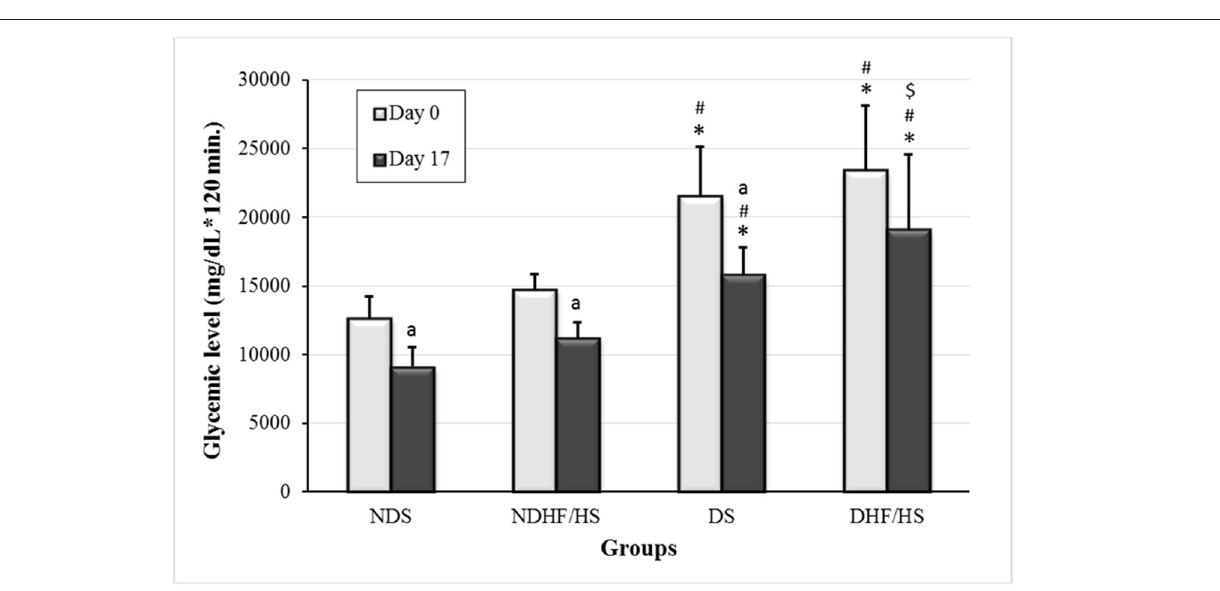
in AUC between days 0 and 17 of pregnancy of DHF/HS rats ( Figure 2